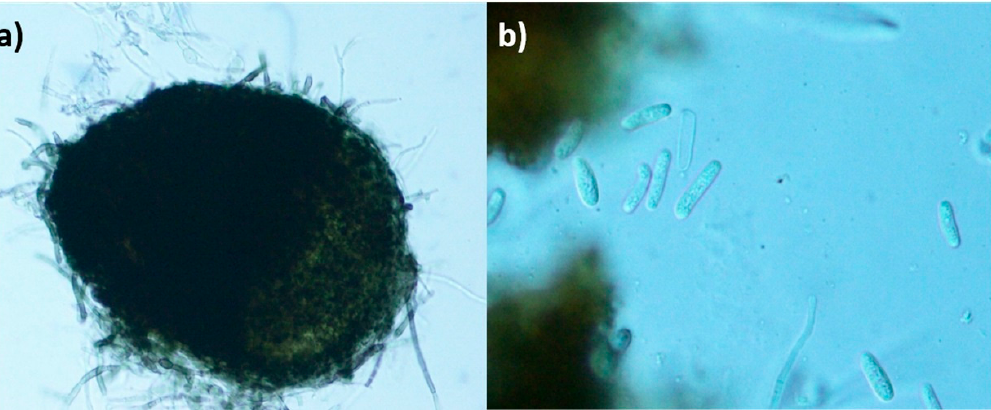
Figure 1. Morphological characteristics of the D. tragani CF-090383 strain. ( a ) Cylindrical brown pycnidia. ( b ) Cylindrical hyaline aseptate conidia and paraphyses.